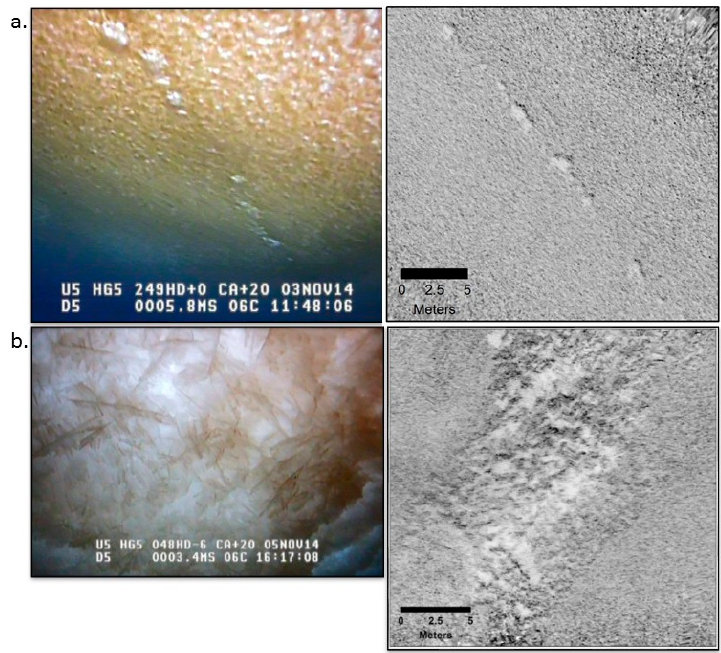
Figure 11. Broad scale textural features identified in the backscatter imagery processed at 5 cm;